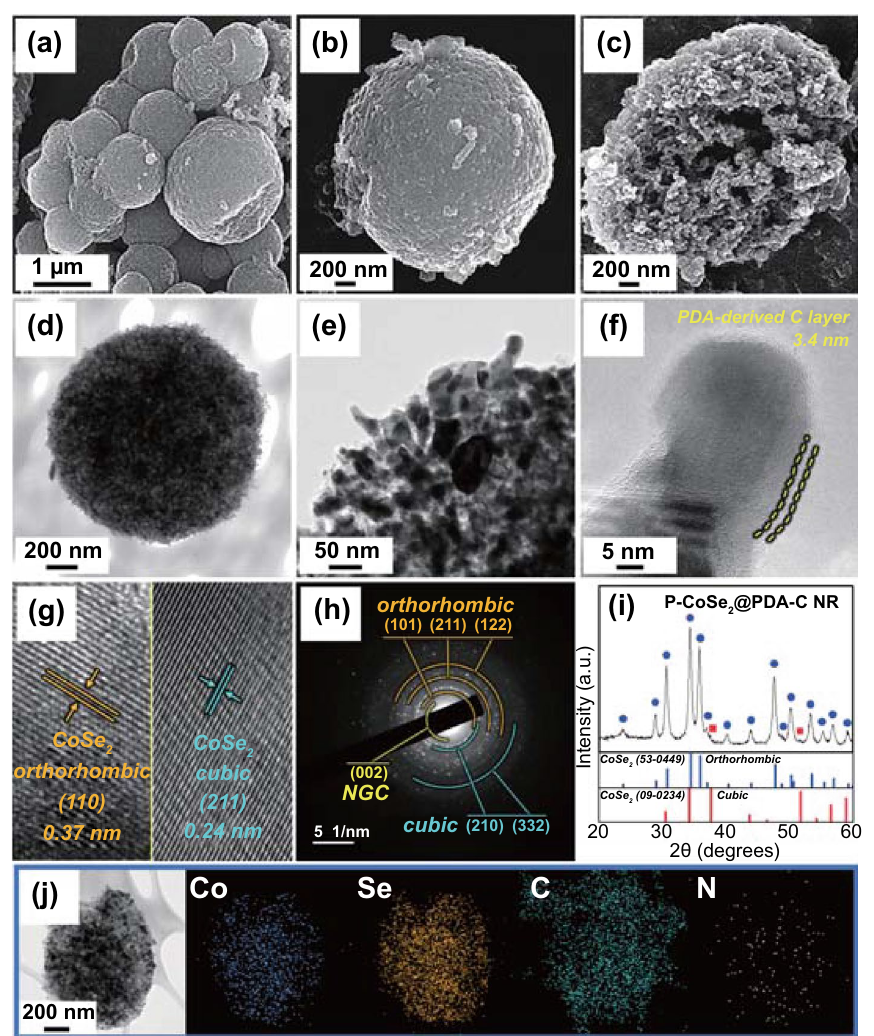
Fig. 3 Morphologies, SAED, XRD patterns, and elemental mapping images of the P-CoSe 2 @PDA-C NR microspheres: a , b FE-SEM images, c fractured sphere’s FE-SEM image, d – f TEM images, g HR-TEM image, h SAED pattern, i XRD pattern, and j elemental mapping